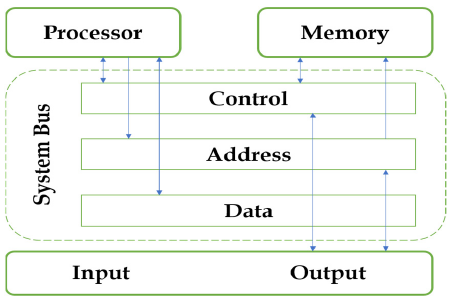
Figure 2. Computational architecture of Von Neumann.